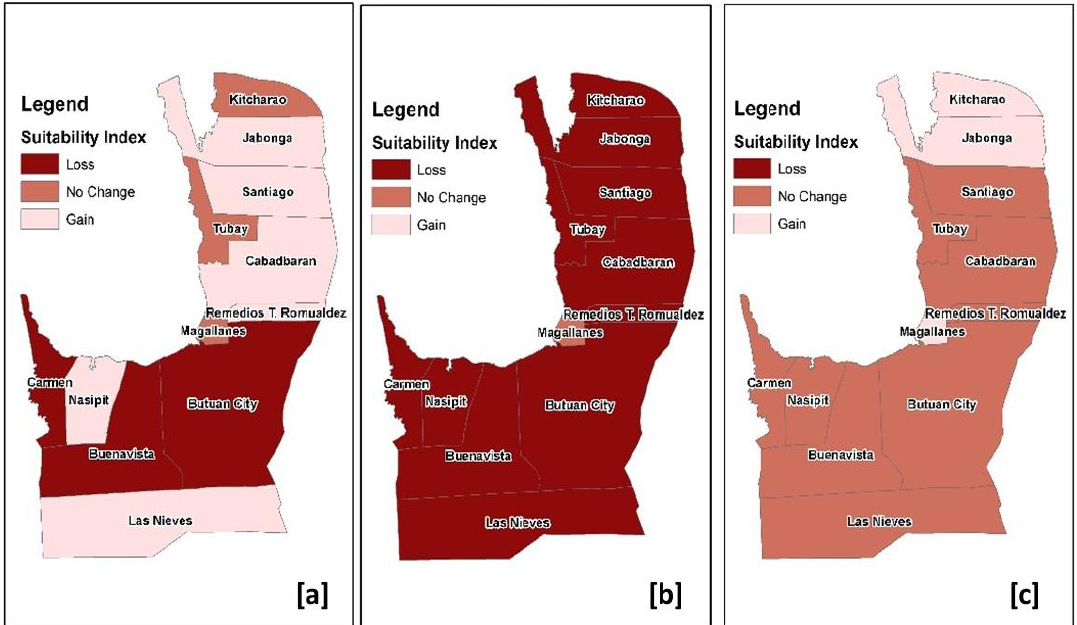
Figure 3. Sensitivity (suitability) index of Rice [a], Corn [b], and Banana [c] in Agusan del Norte.